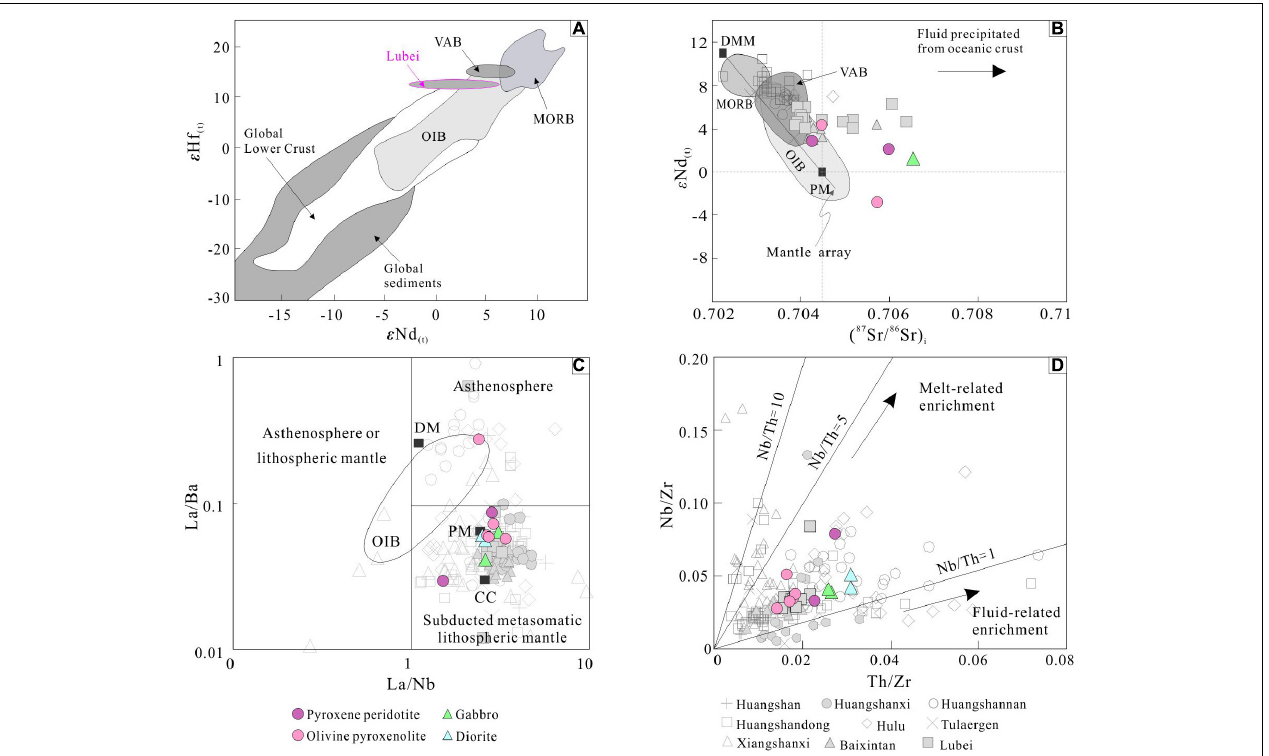
FIGURE 7 | Plot of ε Nd ( T ) versus ε Hf ( T ) (A) , 87 Sr/ 86 Sr versus ε Nd ( T ) (B) , La/Nb versus La/Ba (C) , and Th/Zr versus Nb/Zr (D) . The data of gray symbols are from Supplementary Appendix 1 . Lower crust and sediments data from Bouvier et al. (2008) and Chauvel et al.